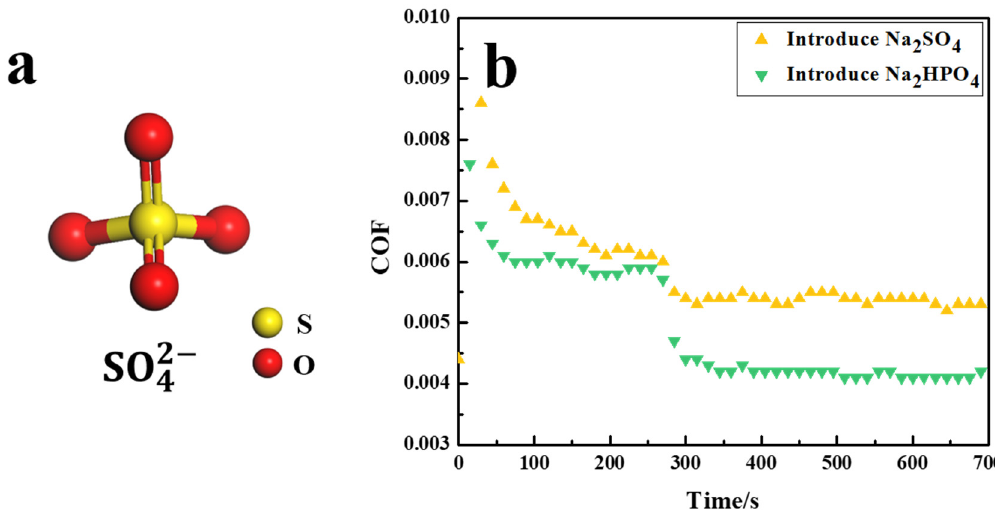
Figure 4. ( a ) Schematic diagram of the structure of SO (cid:2872)(cid:2870)(cid:2879) , ( b ) Variations in the COF of PVPA-modi- fied Ti6Al4V in a NaCl solution sliding against PTFE balls induced by the introduction of anions with different number of double bonds.